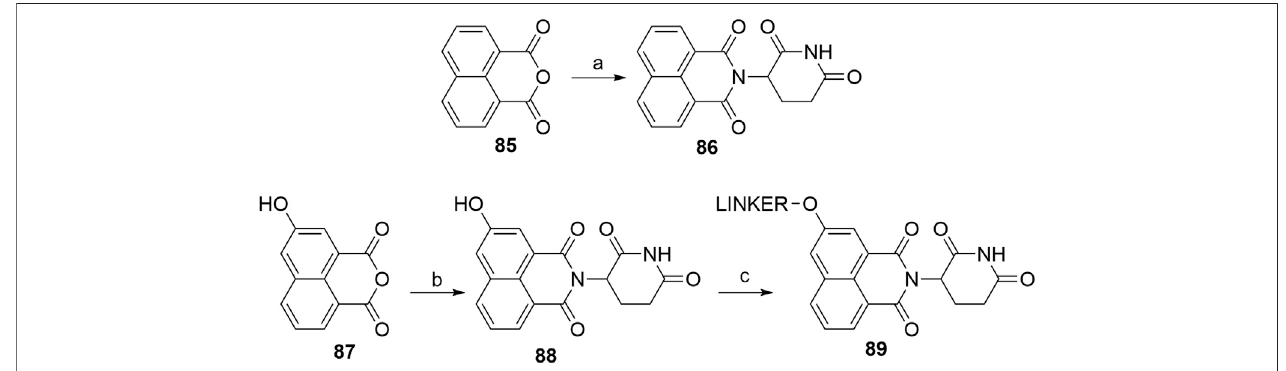
SCHEME 18 | Syntheses of tricyclic imide moiety 86 and its 5-hydroxyl derivative 88 . Reagents and conditions: a) tert -butyl (2,6-dioxopiperidin-3-yl)carbamate 2 , CF